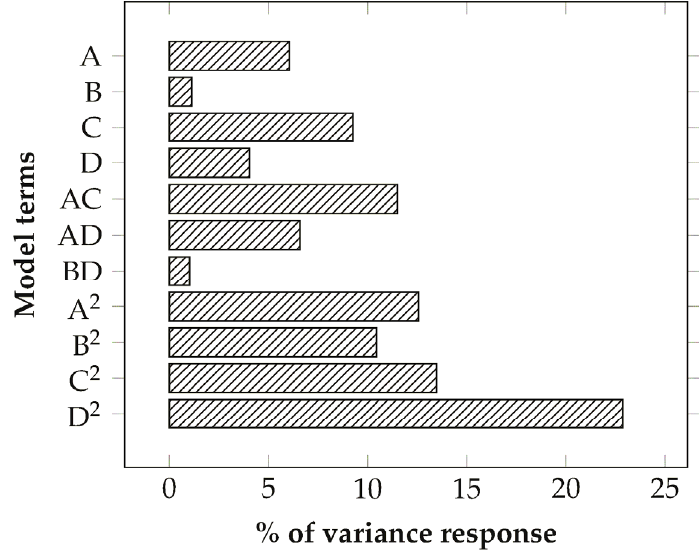
Figure 6. Proportionate contribution of each term of the quadratic model to the R 2